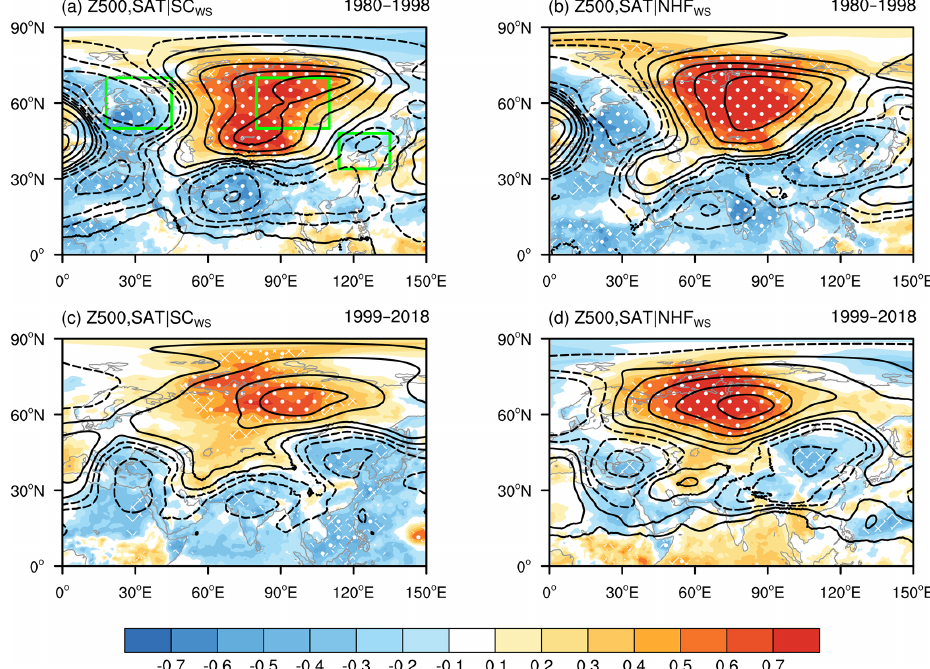
Figure 5. The correlation coefficients between SC WS ×− 1 (a, c) , NHF WS (b, d) and surface air temperature (shading) and geopotential height at 500hPa (contour) from 1980 to 1998 (a, b) and from 1999 to 2018 (c, d) . The white dots (hatching) indicate that the correlation coefficients (in shading) exceeded the 95% (90%) confidence level ( t test). The green boxes represent the anomalous cyclonic or anticyclonic centers in AM. The linear trend is